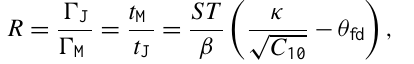
Fig. 4. Same as Fig. 3 with h = 9 m. The lowest wind speed U 10 ≈ 6 . 0 m s − 1 is not shown, as the next one already gives us a deep- water limit.